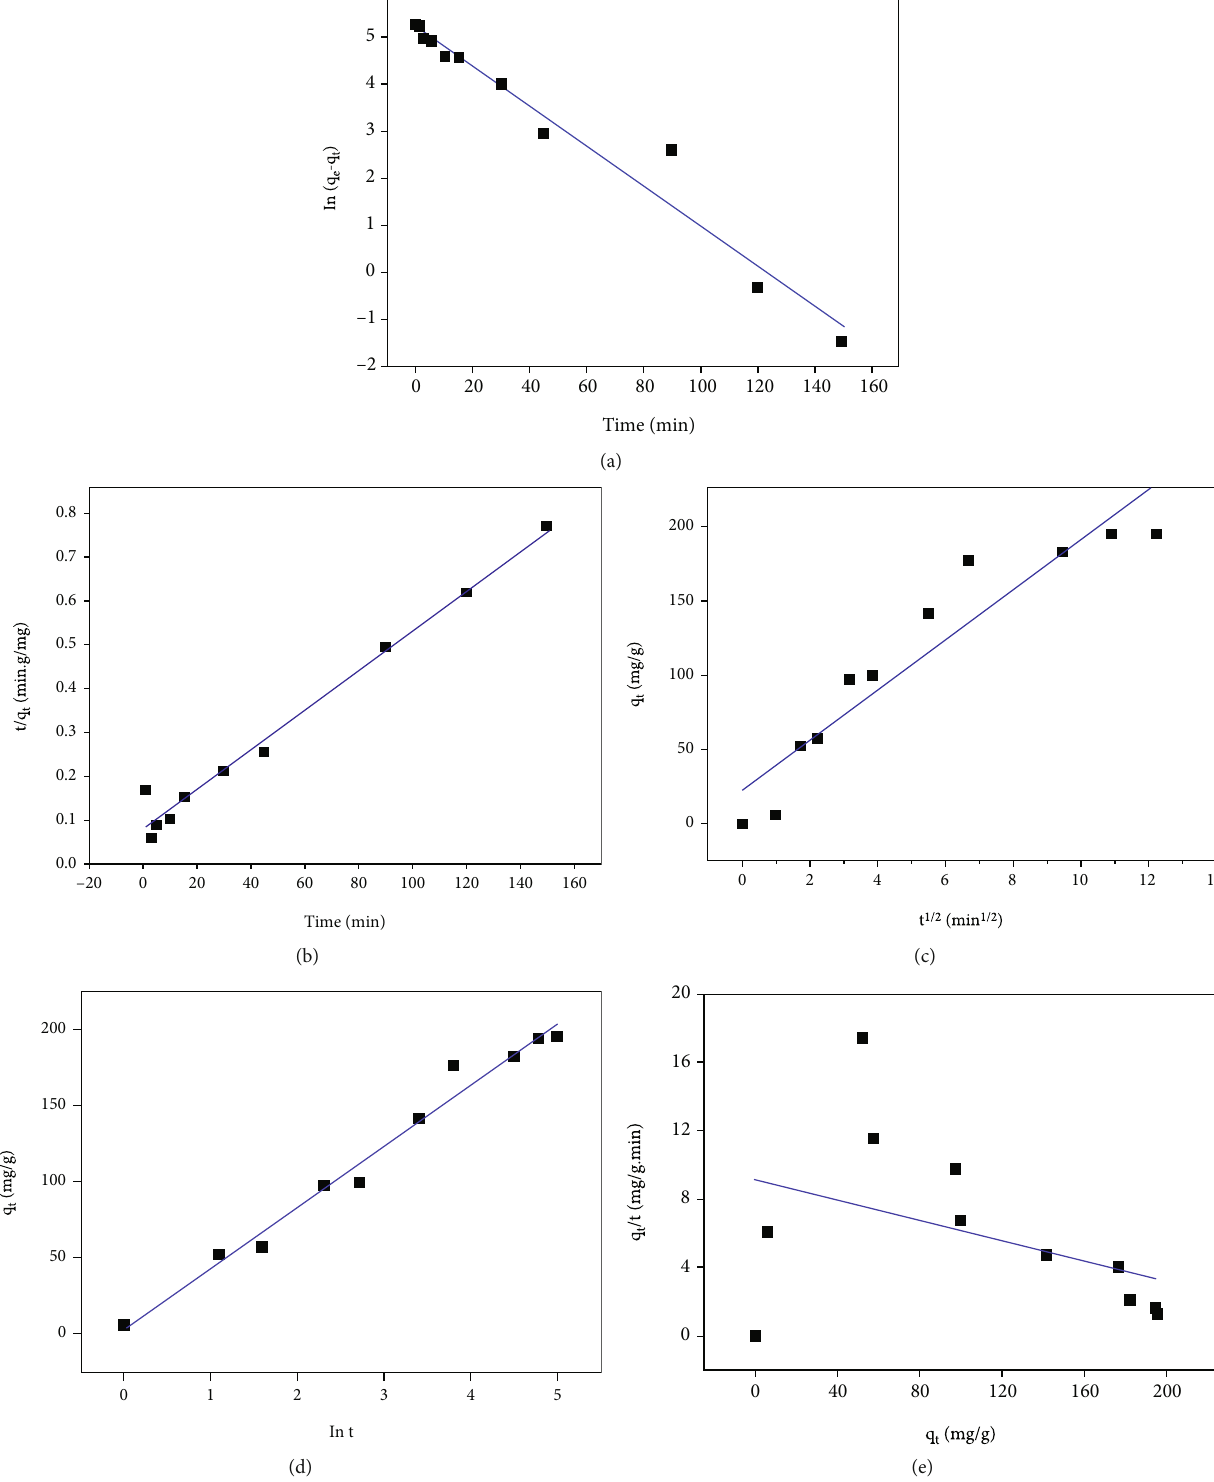
Figure 9: The plots of (a) PFO, (b) PSO (type 1), (c) intraparticle di ff usion, and (d) Elovich and PSO (type 4)